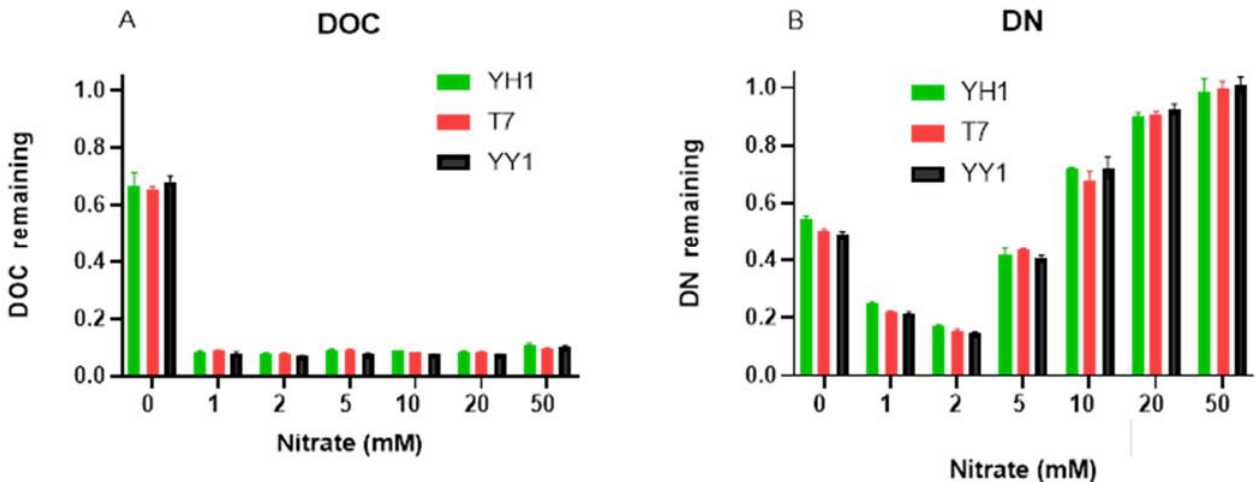
Figure 3. Residual DOC and DN (as a fraction of initial amounts) after 96 h incubation of the three strains with increasing nitrate concentrations. ( A ) DOC remained and ( B ) DN remained. All cultures initiated at an OD 600 of 0.05 at time zero with 20 mg/L RDX and 1 g/L glucose. Triplicates were used in all treatments, and the results are average ± standard deviation.